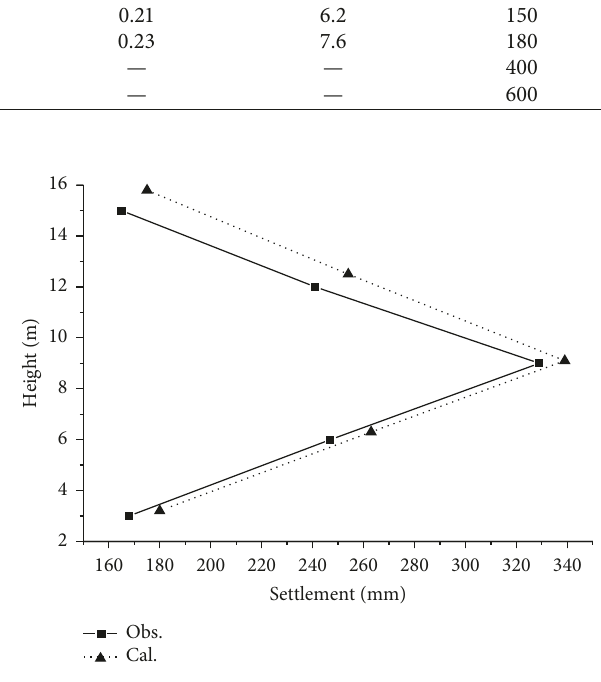
Figure 7: Comparison between observed and calculated settle- ments during